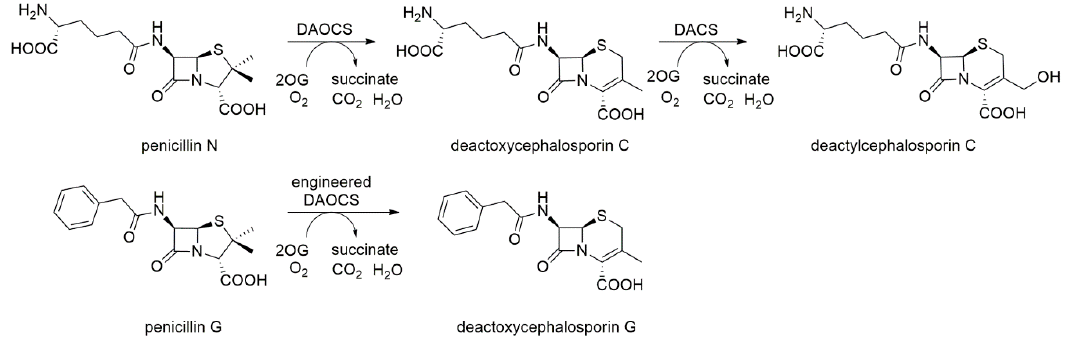
Figure 7. Reactions catalyzed by DAOCS and DACS in the biosynthesis of cephalosporins.